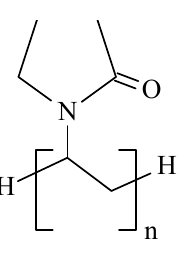
Figure 1. The structure of CNHox.